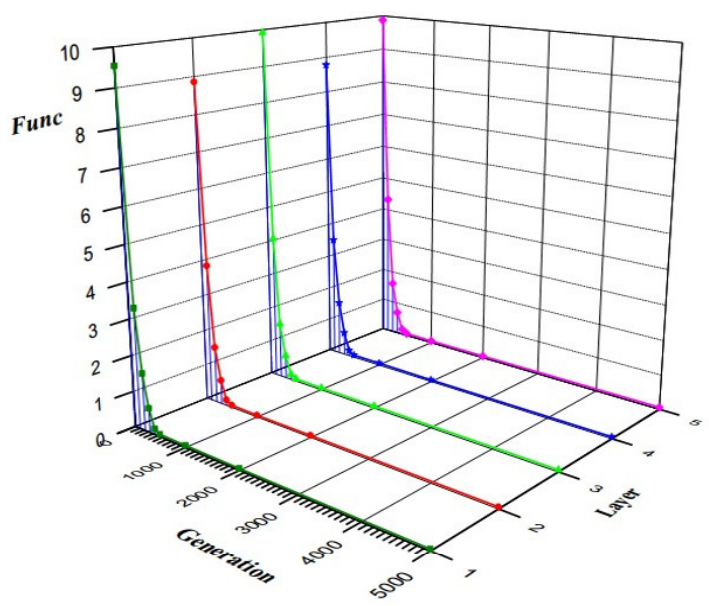
Figure 8. The performance of JADE for intrinsic parameter calibration. Table 1. Values of the intrinsic parameters (mm, ◦